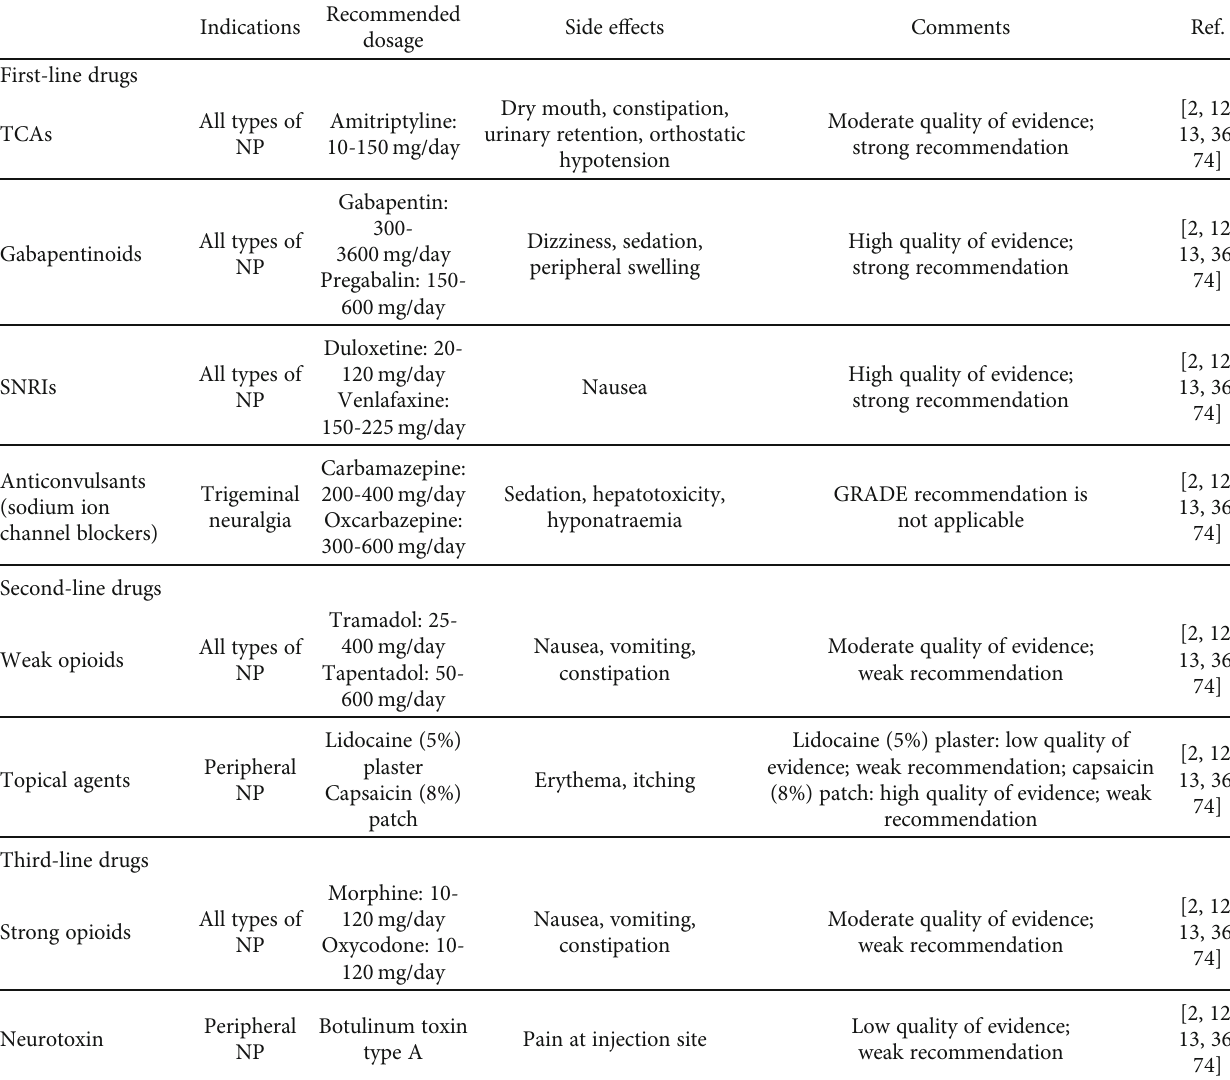
Table 3: Pharmacological therapeutic options for neuropathic